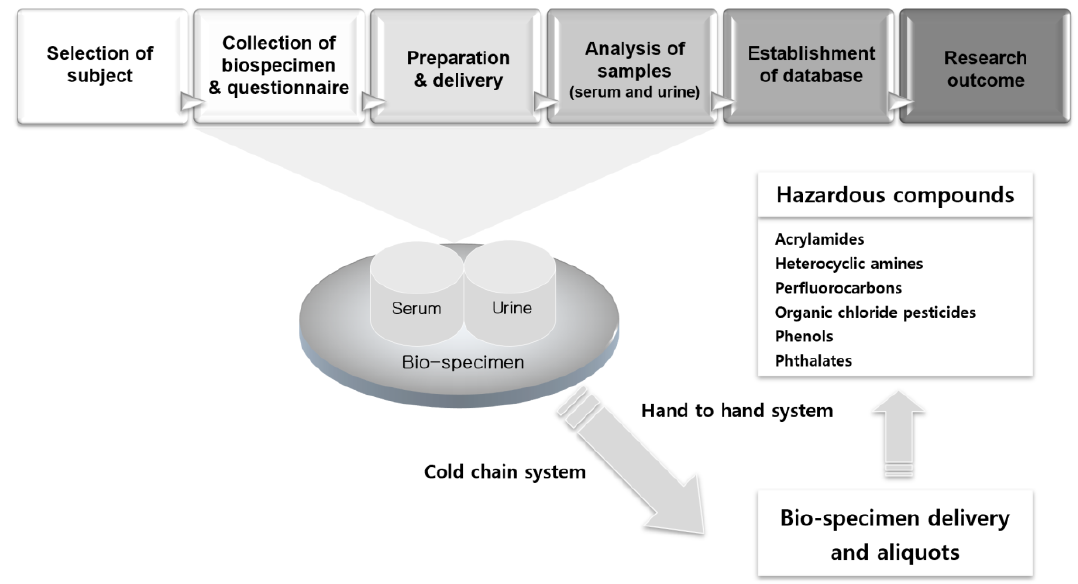
Figure 1. Flow-chart for the human biomonitoring survey .